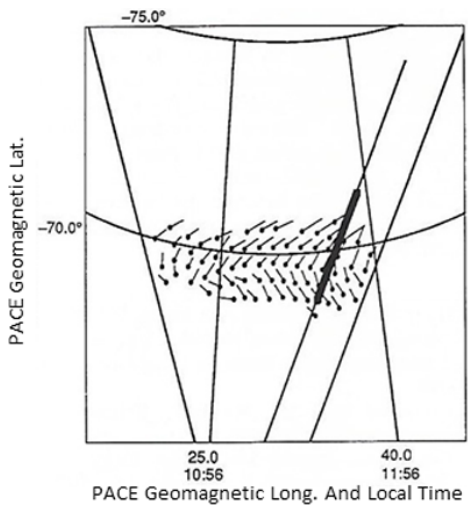
Figure 8. A two-dimensional plot of plasma convection over Antarctica, as observed with the Halley HF Radar. Each dot in the figure indicates the latitude and local time of the measurement, and the length and direction of each line represents the magnitude and direction of the velocity. Note that south is at the top of the fig- ure and west is to the right. The line extending from the bottom upwards toward the right, and superimposed by a bold line, is the trajectory of the DMSP spacecraft. The bold line represents the in- terval at which it is detecting the cusp plasma shown in the previous figure. Reproduced from Fig. 2 of Baker et al. (1990). Note: MLT – magnetic local time.